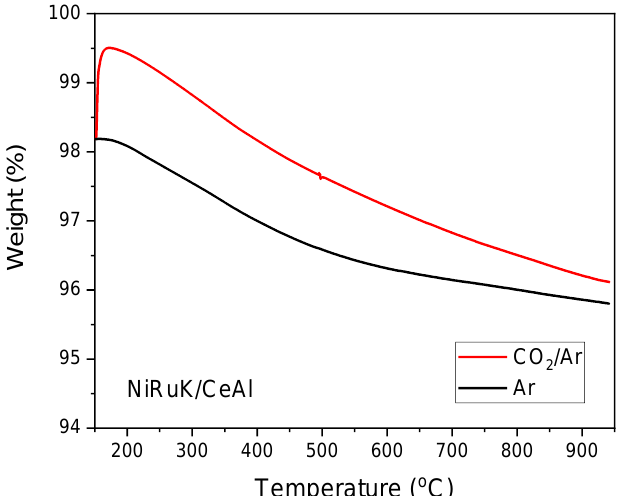
Figure 4. Weight change of NiRuK/CeAl with increasing temperature under Ar and CO 2 /Ar flows.